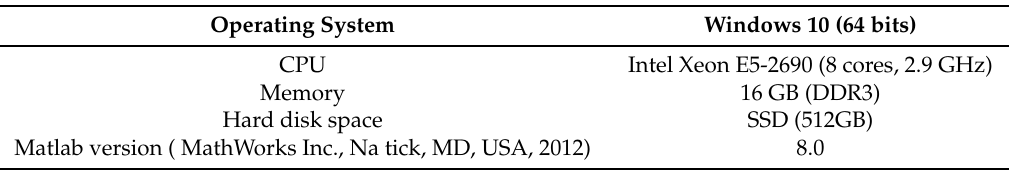
Table 1. Configuration of the work station.